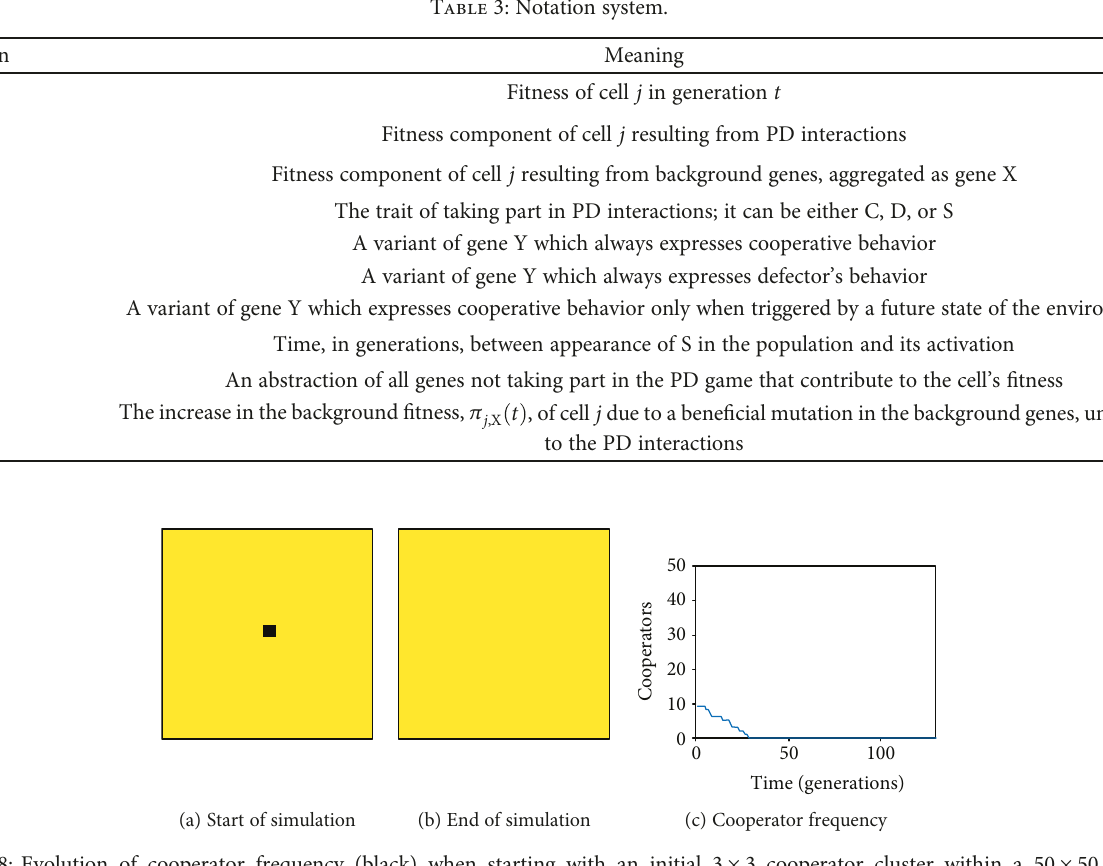
Figure 8: Evolution of cooperator frequency (black) when starting with an initial 3 × 3 cooperator cluster within a 50 × 50 grid of defectors (yellow).